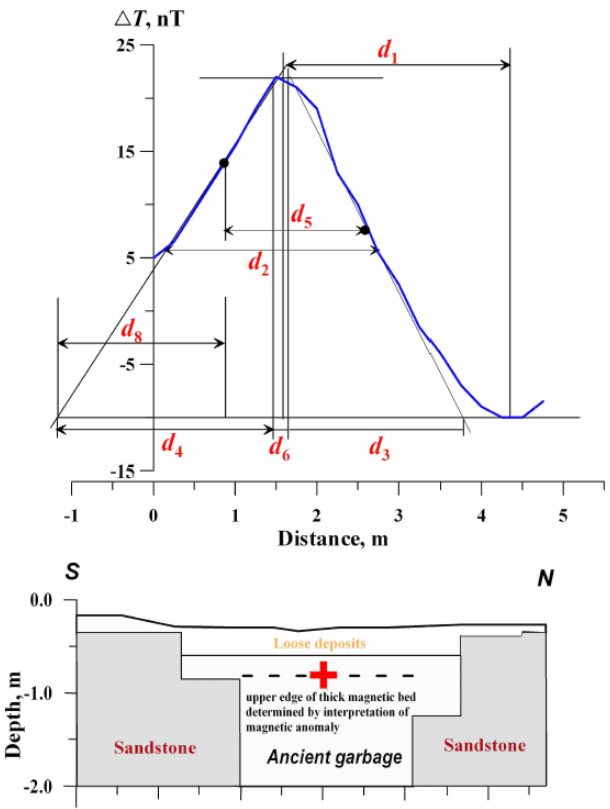
Fig. 11. Interpretation of magnetic anomaly due to ancient garbage at the site of Ashqelon-Marina (Southern Israel) (after Eppelbaum et al., 2000a, with